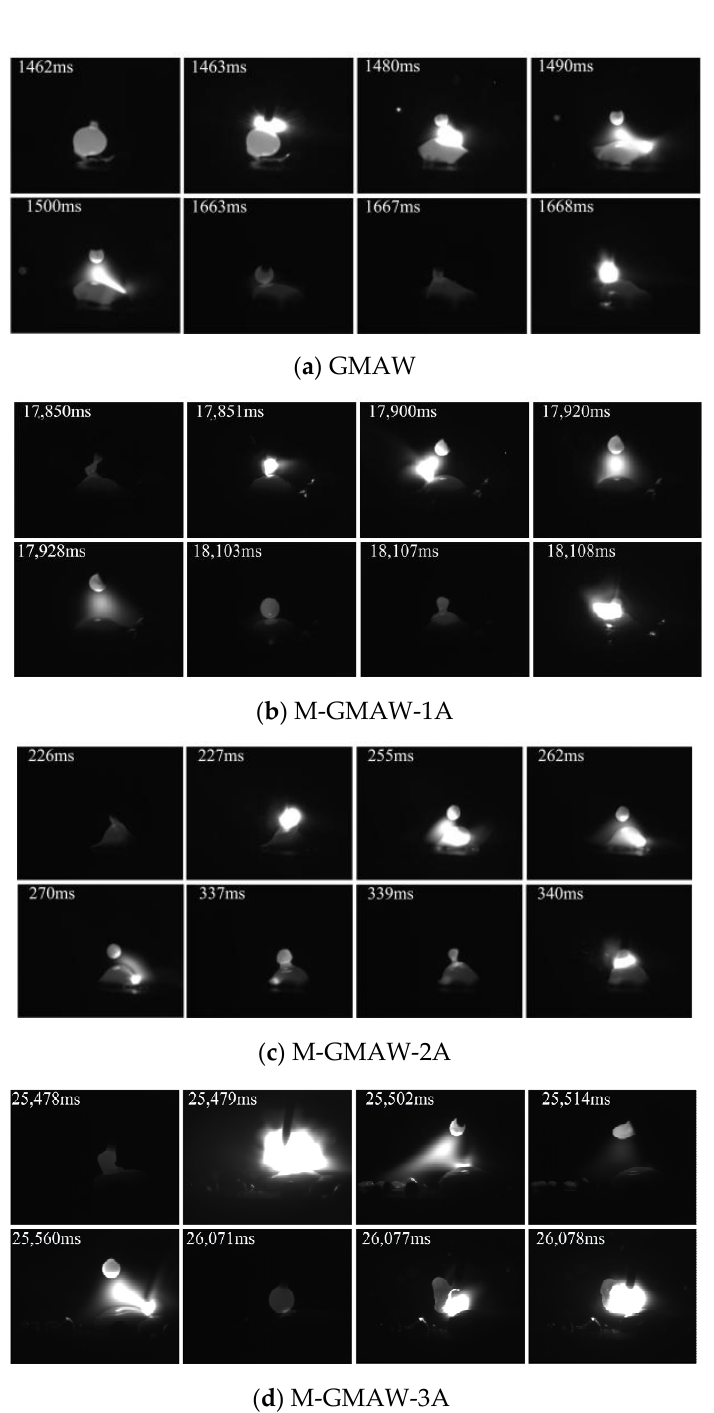
Figure 2. Wire feeding speed of 2 m/min.